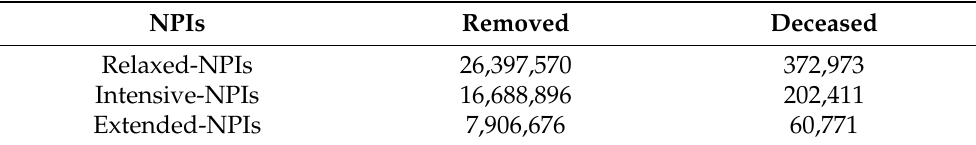
Table 1. Historical strain without vaccination. Cumulative numbers of individuals removed and hospital deaths on 30 June